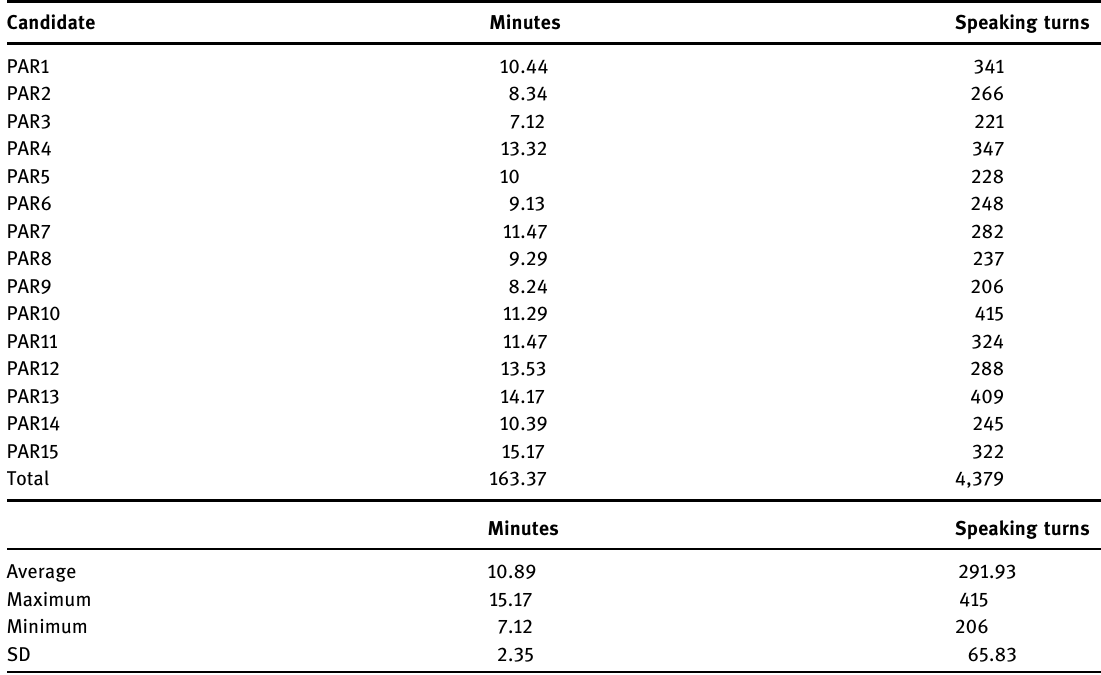
Table 1: Duration and speaking turns per